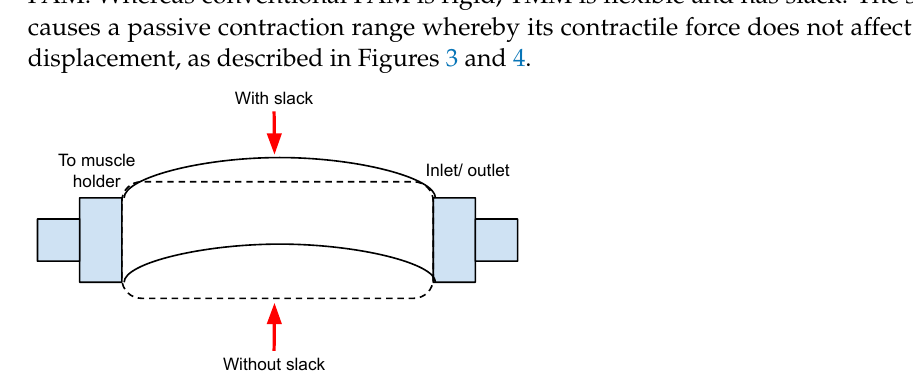
Figure 3. Comparison between a muscle with slack and a muscle without slack.